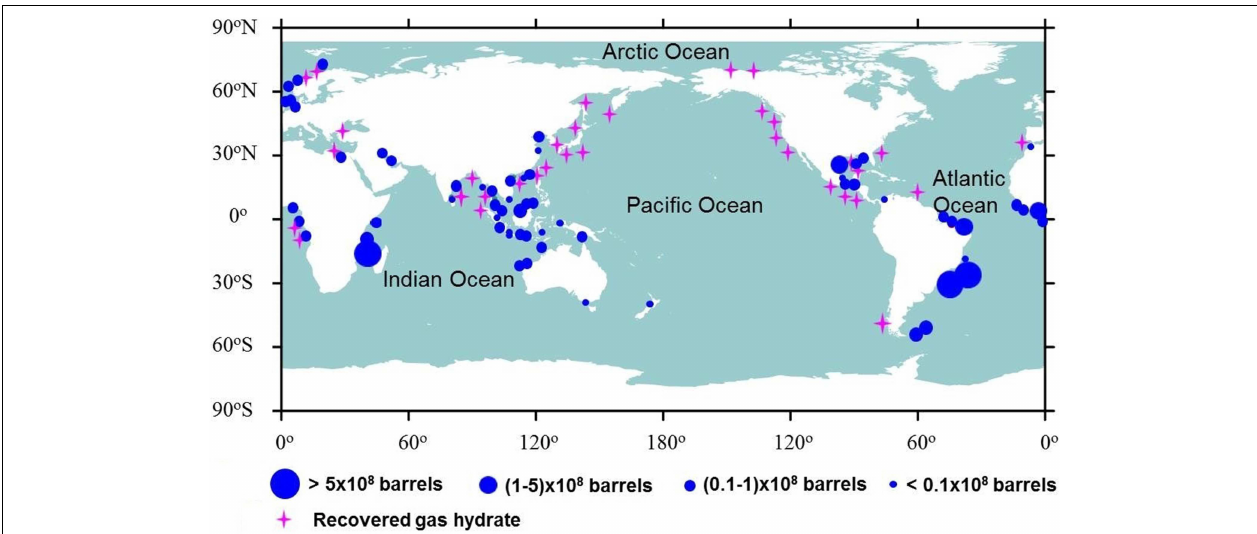
FIGURE 1 | The global new discoveries of offshore oil-gas exploration (Zhao et al., 2014) and an inventory of marine methane hydrate deposits (Ruppel and Noserale, 2012). Purple star symbols show the gas hydrates that have been discovered, while blue dots show those offshore oil-gas discoveries in